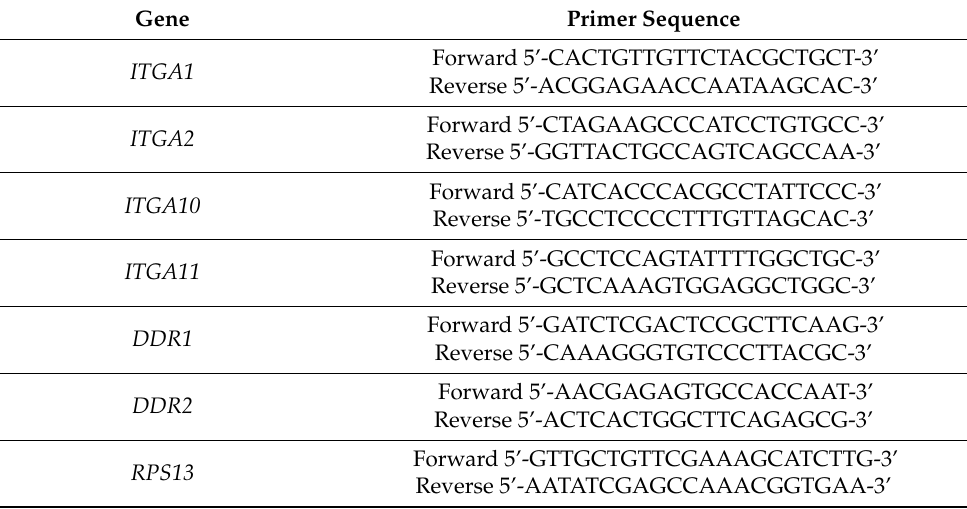
Table 3. RT-qPCR primer